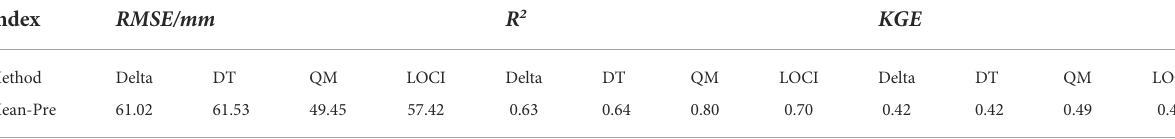
TABLE 2 Comparison of downscaling methods of the historical monthly precipitation from CMIP6. Index Method